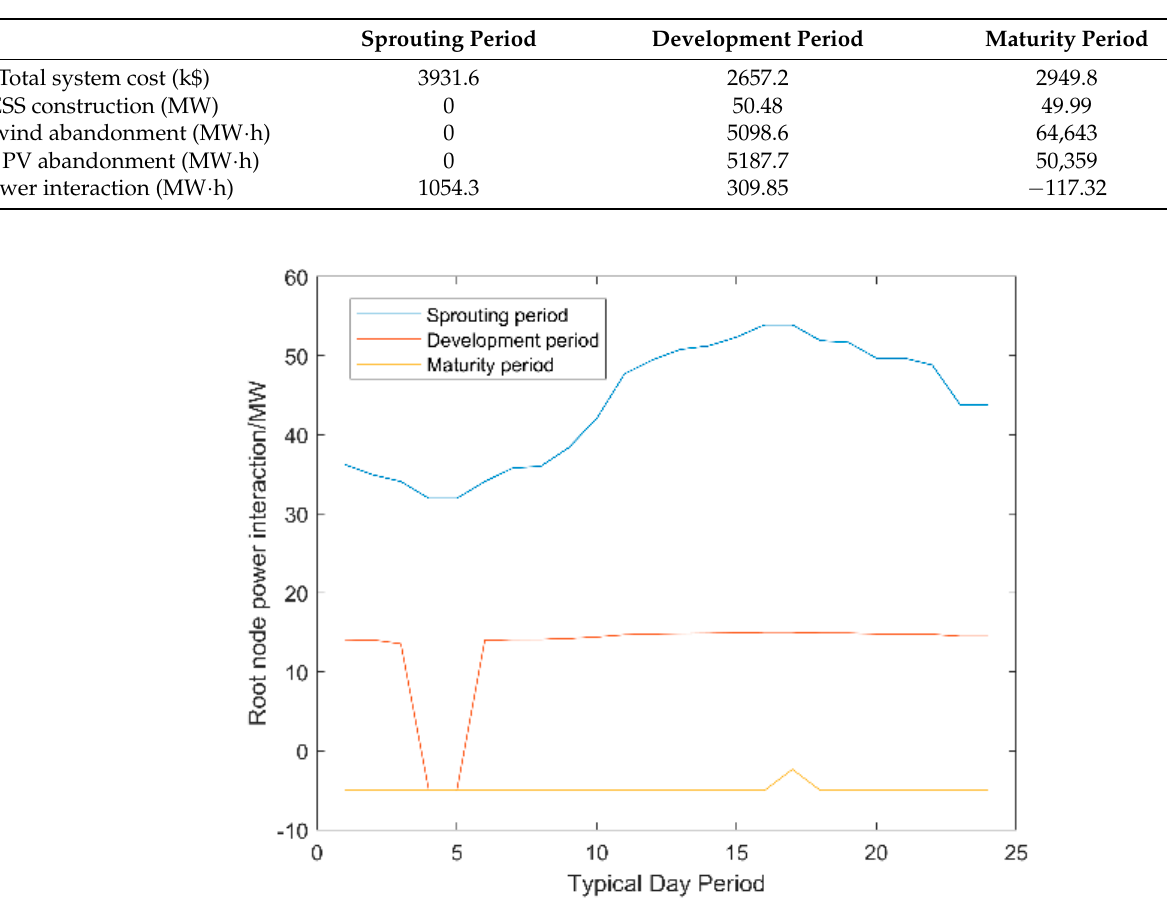
Figure 3. Power interaction of distribution network 1 root node in each typical period.